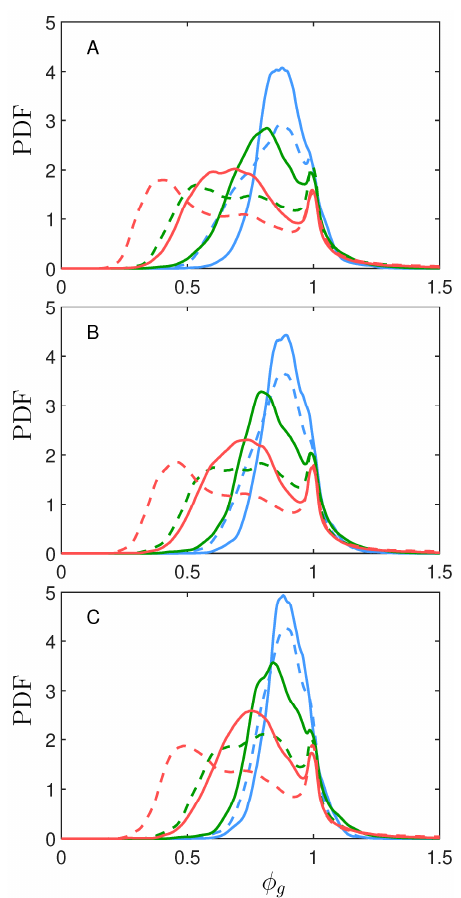
Figure 2. PDFs of φ g in the region corresponding to 0.01 ≤ c ≤ 0.99 at different locations A, B and Figure 2. PDFs of 𝜙 (cid:3034) in the region corresponding to 0.01 ≤ 𝑐 ≤ 0.99 at different locations A, B Figure 2. PDFs of 𝜙 (cid:3034) in the region corresponding to 0.01 ≤ 𝑐 ≤ 0.99 at different locations A, B Figure 2. PDFs of 𝜙 (cid:3034) in the region corresponding to 0.01 ≤ 𝑐 ≤ 0.99 at different locations A, B Figure 2. PDFs of 𝜙 (cid:3034) in the region corresponding to 0.01 ≤ 𝑐 ≤ 0.99 at different locations A, B and C (top to bottom) for initial 𝑎 (cid:3031) 𝛿 (cid:3046)(cid:3047) ⁄ = 0.04 ( ), 0.05 ( ) and 0.06 ( ) with and C (top to bottom) for initial 𝑎 (cid:3031) 𝛿 (cid:3046)(cid:3047) ⁄ = 0.04 ( ), 0.05 ( ) and 0.06 ( ) with and C (top to bottom) for initial 𝑎 (cid:3031) 𝛿 (cid:3046)(cid:3047) ⁄ = 0.04 ( ), 0.05 ( ) and 0.06 ( ) with and C (top to bottom) for initial 𝑎 (cid:3031) 𝛿 (cid:3046)(cid:3047) ⁄ = 0.04 ( ), 0.05 ( ) and 0.06 ( ) with C (top to bottom) for initial a d / δ st = 0.04 ( ), 0.05 ( ) and 0.06 ( ) with u mean / S b , st = 5.0 𝑢 (cid:3040)(cid:3032)(cid:3028)(cid:3041) 𝑆 (cid:3029),(cid:3046)(cid:3047) ⁄ = 5.0 (continuous line) and 10.0 (dashed line). 𝑢 (cid:3040)(cid:3032)(cid:3028)(cid:3041) 𝑆 (cid:3029),(cid:3046)(cid:3047) ⁄ = 5.0 (continuous line) and 10.0 (dashed line). 𝑢 (cid:3040)(cid:3032)(cid:3028)(cid:3041) 𝑆 (cid:3029),(cid:3046)(cid:3047) ⁄ = 5.0 (continuous line) and 10.0 (dashed line). 𝑢 (cid:3040)(cid:3032)(cid:3028)(cid:3041) 𝑆 (cid:3029),(cid:3046)(cid:3047) ⁄ = 5.0 (continuous line) and 10.0 (dashed line). (continuous line) and 10.0 (dashed